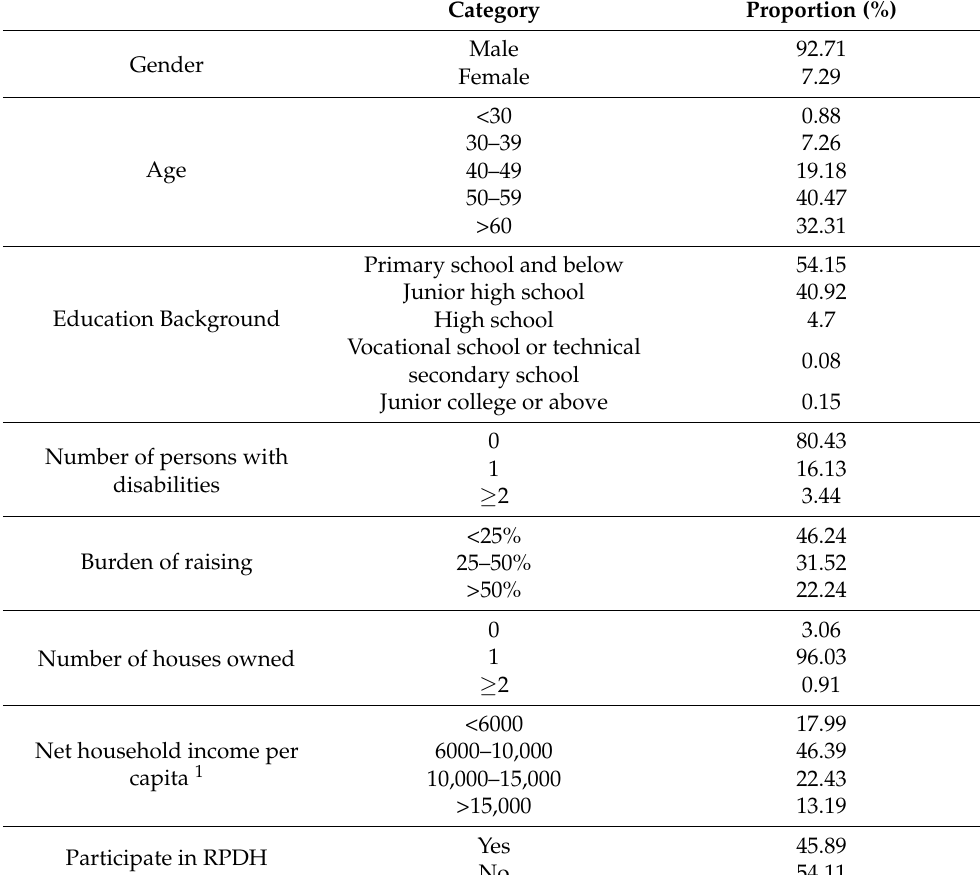
Table 1. Basic information of